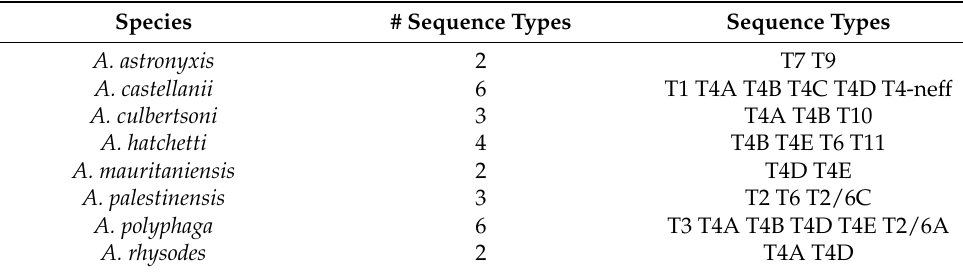
Table 5. Acanthamoeba species with standard strains placed in multiple sequence types. Species # Sequence Types Sequence